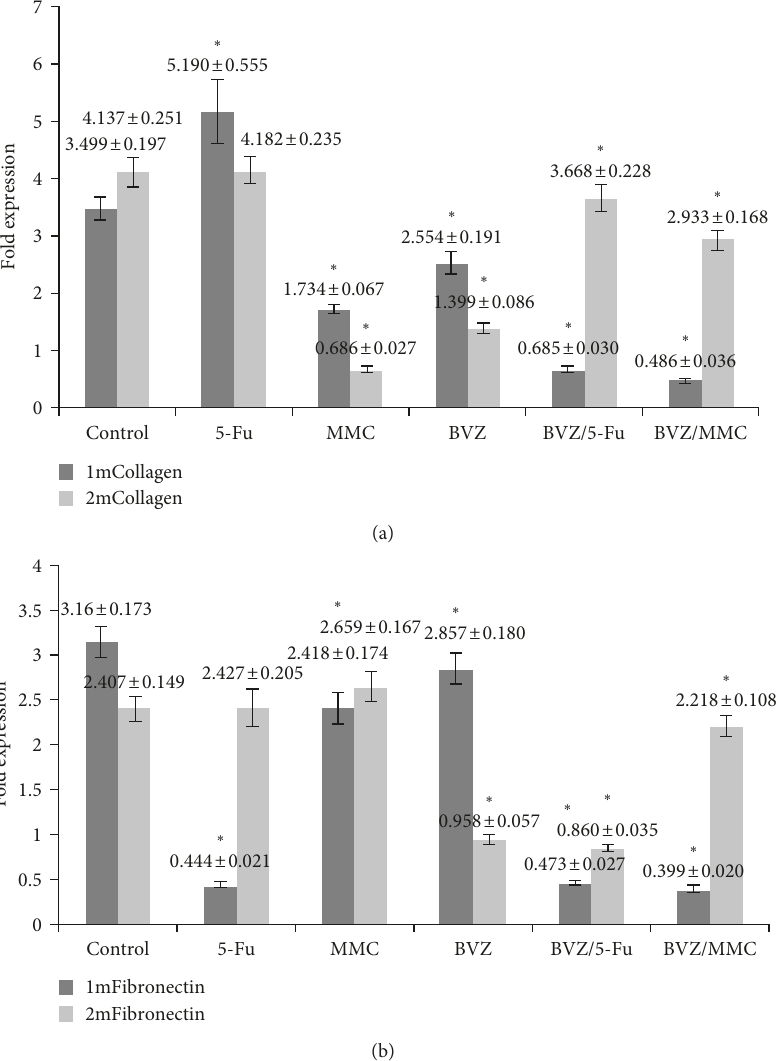
Figure 8: mRNA expression levels of fibrotic markers in the tissues of filtering blebs. In the bevacizumab (BVZ), 5-fluorouracil (5-Fu) +BVZ, and mitomycin C (MMC) +BVZ groups, the mRNA expression levels of type I collagen (a) and fibronectin (b) in filtering blebs were significantly lower than those in the control group. The data in the MMC and 5-Fu treatment groups were not significantly different from P 0 . those in the control group after both 1 and 2 months ( ∗ <